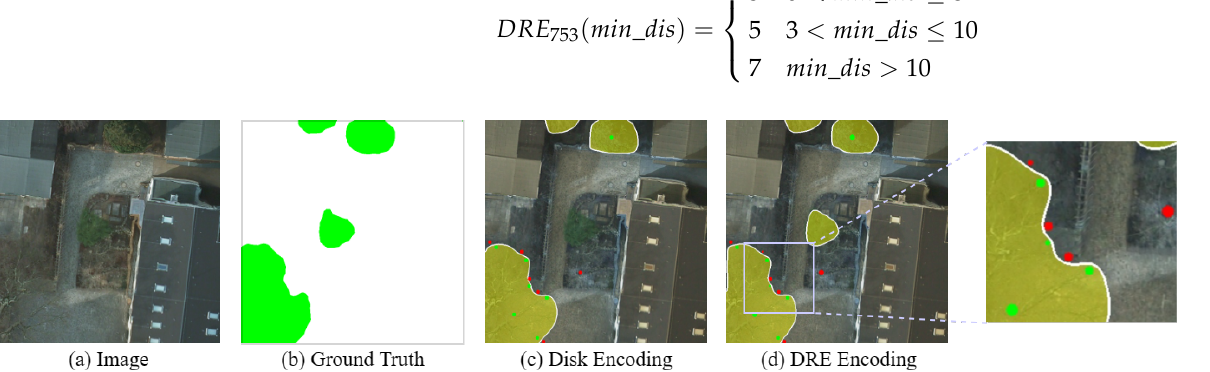
Figure 7. An example for disk encoding and DRE. The green and red points stand for positive and negative clicks, respectively. All clicks in disk encoding are encoded with the same radius, while the clicks close to the mask boundary have a smaller encoding radius in DRE. Through such a differentiated encoding method, we tell the network the different influences of each click and achieve higher accuracy with the same number of clicks.